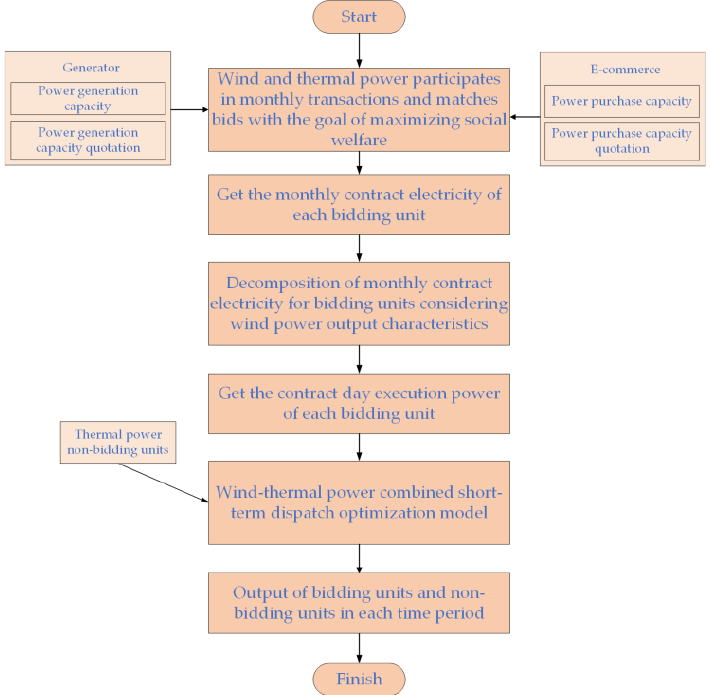
Figure 4. Technical